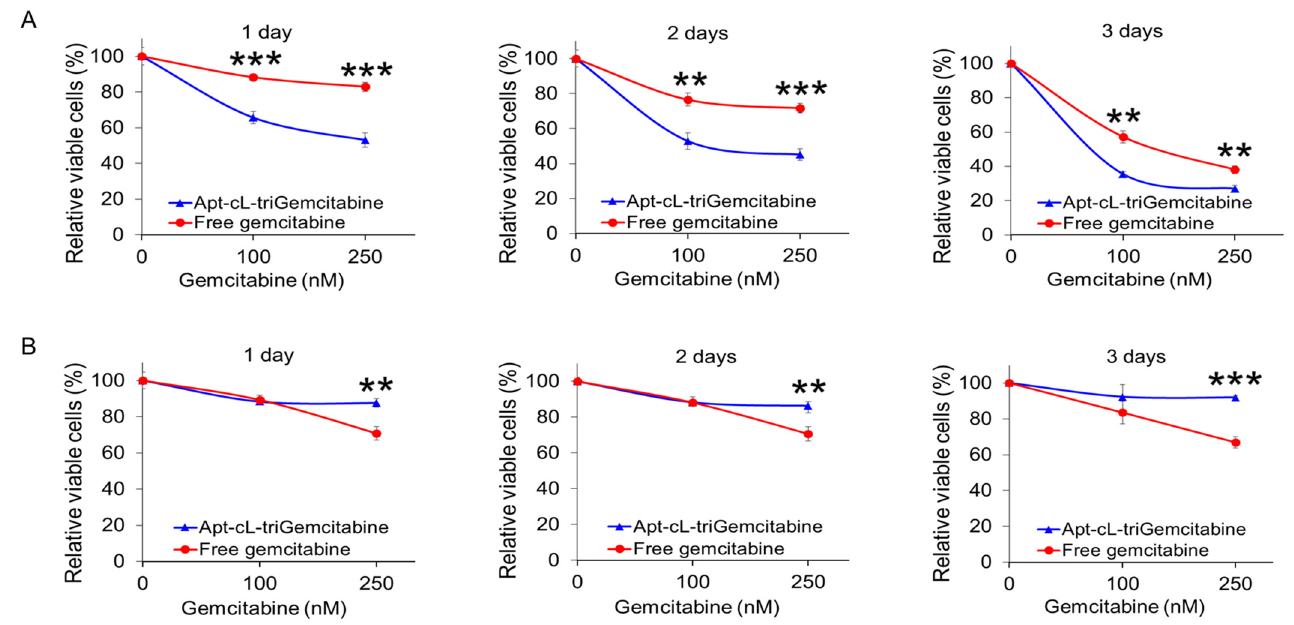
Figure 7. Apt–cL–triGemcitabine conjugate treatment selectively inhibits TNBC cell proliferation with few side effects on off-target cells. Cultured MDA-MB-231 (TNBC) cells ( A ) and T47D (non-TNBC) cells ( B ) were treated with Apt–cL–triGemcitabine conjugate or free drug at equimolar amounts of gemcitabine as indicated. Resultant changes in cell proliferation rates (%) were kinetically measured using a CCK-8 cell proliferation assay kit at day 1, 2, and 3 post treatment. Untreated cells were used as a background baseline control. Significant differences between groups are indicated with asterisks. p ≤ 0.05 was considered significant. **: p ≤ 0.01; ***: p ≤ 0.001 (Student’s t-test).